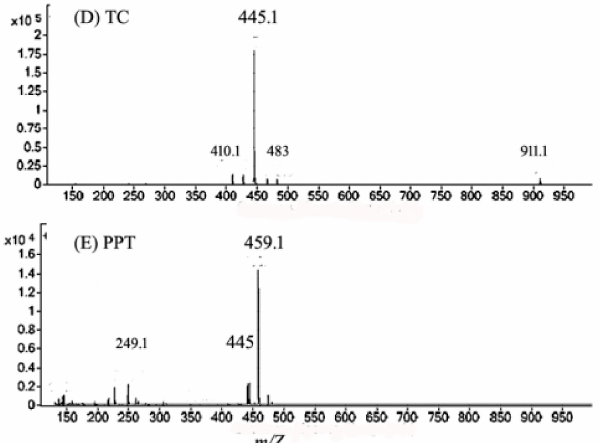
Figure 4. Total ion chromatogram of an HPLC-MS analysis of a ( A ) PBS (pH 7.8), ( B ) 50 mg/L TC solution, and ( C ) TC treated with blue light illumination at 2.0 mW/cm 2 for 120 min. ( D ) Electron ionization mass spectra of TC, and the photolysis product (E, PPT) from TC treated with blue light illumination for 2 h. Ion spectra product of [M–H] + for a blue-light-treated TC solution (pH 7.8). The selected precursor ion is m/z 445, and the proposed fragments are shown.